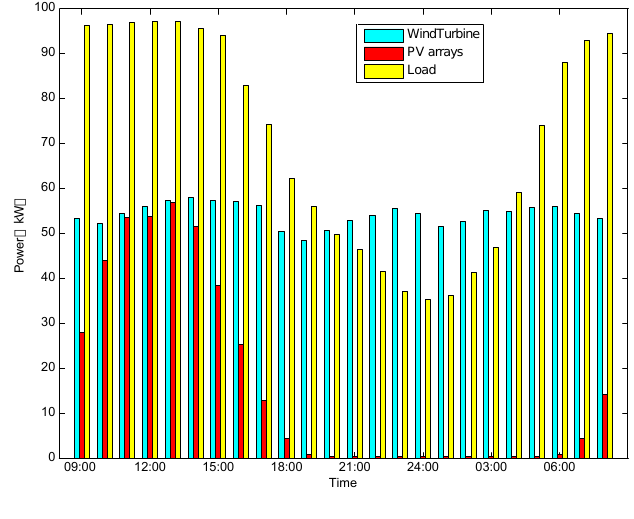
Figure 7. Hourly average output power of wind turbines and PV arrays and the hourly average demand of load.